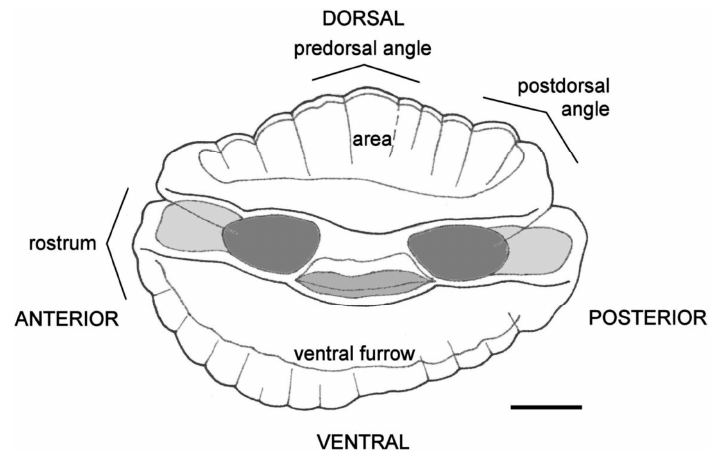
Figure 4. Typical otolith of adult Gadiculus thori (Total length (TL) 144 mm, standard length (SL) 135 mm), Kvinnheradfjord, Hardanger, Norway, showing the medially positioned sulcus acusticus and associated structures. Colliculi dark grey; pseudocolliculum medium grey; very low and indistinct colliculi-like areas light grey. Scale bar: 1 mm. Fishes 2017 , 2 , 15 The outline of G. argenteus otoliths is stoutly pear-shaped, thus short and high (Figure 5). It can also be described as drop-shaped. The posterior end is bluntly pointed, forming a wide angle, and may be somewhat indented in the largest otoliths. In cases where the posterior end is truncated it is running obliquely to the longitudinal axis of the otolith. The anterior end is regularly rounded with a ventral part that is slightly more prominent than its dorsal part. In full-grown otoliths an indentation often occurs at the anterior end, separating the rostrum from a somewhat shorter antirostrum. In smaller otoliths, this indentation is absent or is only small and shallow. The otoliths rarely show clear dorsal angles—the ones depicted in Figure 5D,G with a distinct postdorsal angle are unusual exceptions. The otoliths show little variation in shape, and variability is mainly limited to the depth of the ornamentation and the length-height ratio in specimens of equal size (Figure 5). Juvenile otoliths tend to be more slender compared to the adult ones and allometry in their length- height ratio during growth is relatively small.